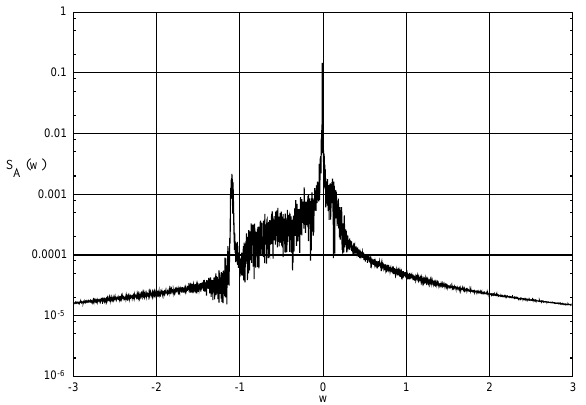
FIG. 10. Spectrum in the case of head-on and long-range collisions with alternating crossing when each bunch collides head-on at two interaction points, and undergoes long-range collisions with n par (cid:1) 32 bunches behind each IP. The horizontal axis is the tune distance to the unperturbed betatron frequency in units of the new incoherent tune shift 2 j : w (cid:1) (cid:2) n 2 Q (cid:3)(cid:1) 2 j . Tracking was performed for 2 17 turns using N (cid:1) 10 4